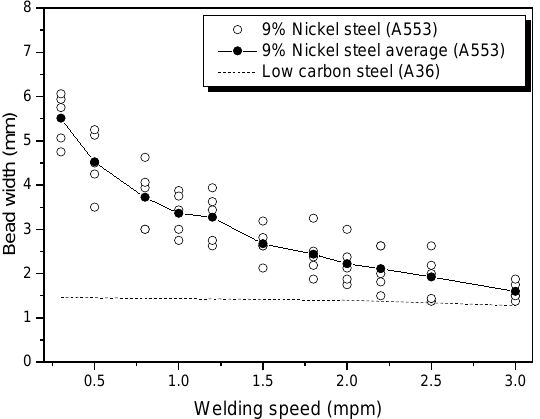
Figure 14. Width fluctuation of surface beads, according to welding speed.